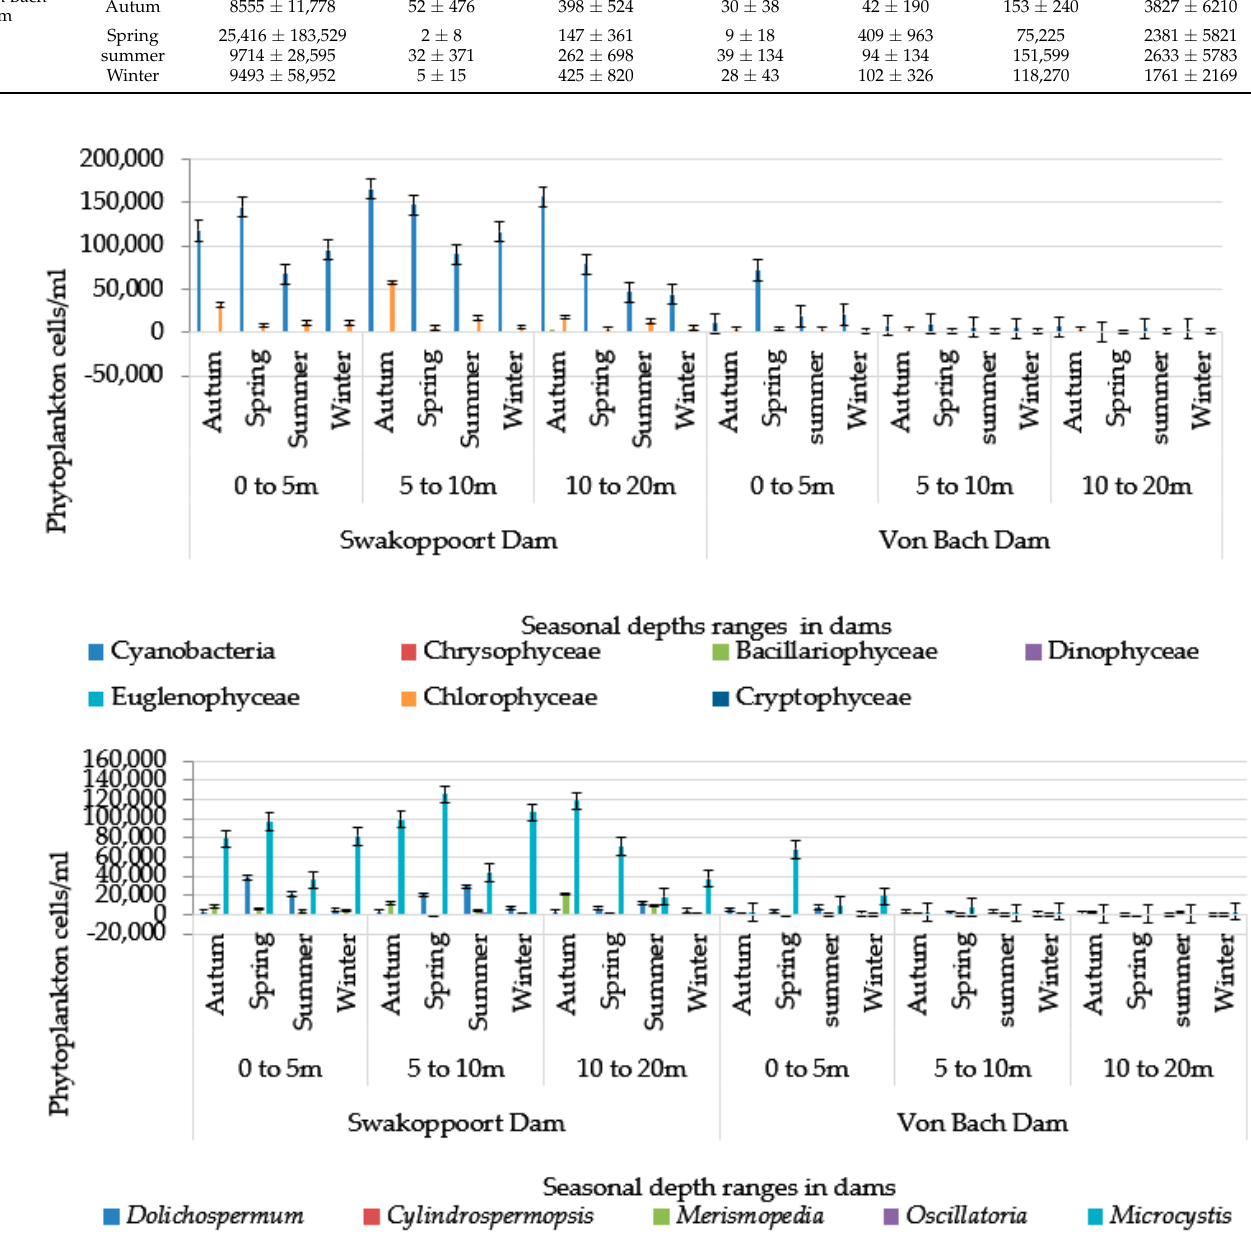
Figure 2. ( a ), Seasonal mean phytoplankton counts in the Swakoppoort and Von Bach dams at different depth ranges and seasons from 2003–2019 and ( b ), the dominant cyanobacteria species in the Swakoppoort and Von Bach dams at different depth ranges and seasons from 2003–2019. Error bars indicate standard deviations.